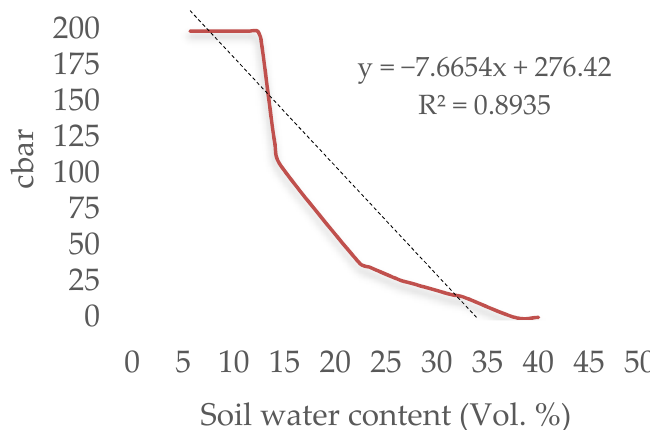
Figure 2. Calibration curve for the soil at the study site.